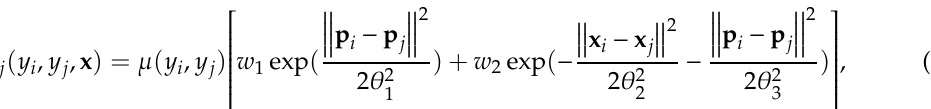
λ and translation parameter ε